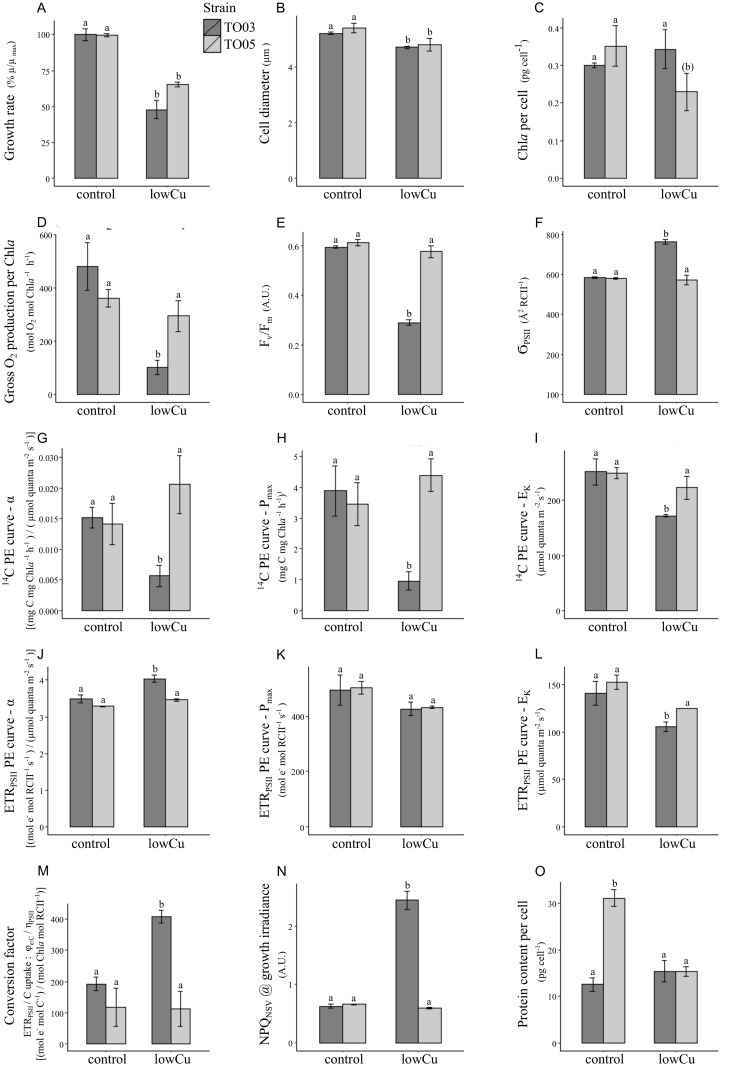
The effects of Cu limitation on growth rate, cell diameter, protein content and a series of photophysiological parameters in two strains of T. oceanica.2A-C, growthrate, cell diameter, and Chla per cell, respectively; 2D-F, gross oxygen production, Fv/Fm, and the absorption cross section of PS II antennae, respectively; 2G-I, 14C PE curve parameters α, Pmax, and EK, respectively; 2J-L, ETRPSII PE curve parameters α, Pmax, and EK, respectively; 2M-O, conversion factor, NPQNSV, and cellular protein content, respectively. The values are mean ± std. error of three biological replicates. Differing letters above bars represent statistically significant changes (p < 0.05) using a 2-way ANOVA with post-hoc interaction analysis (see Methods for details). Note that both strains have the same physiological responses under metal replete conditions. Under low Cu conditions, only growth rate and cell size are significantly reduced in the same manner in both strains.